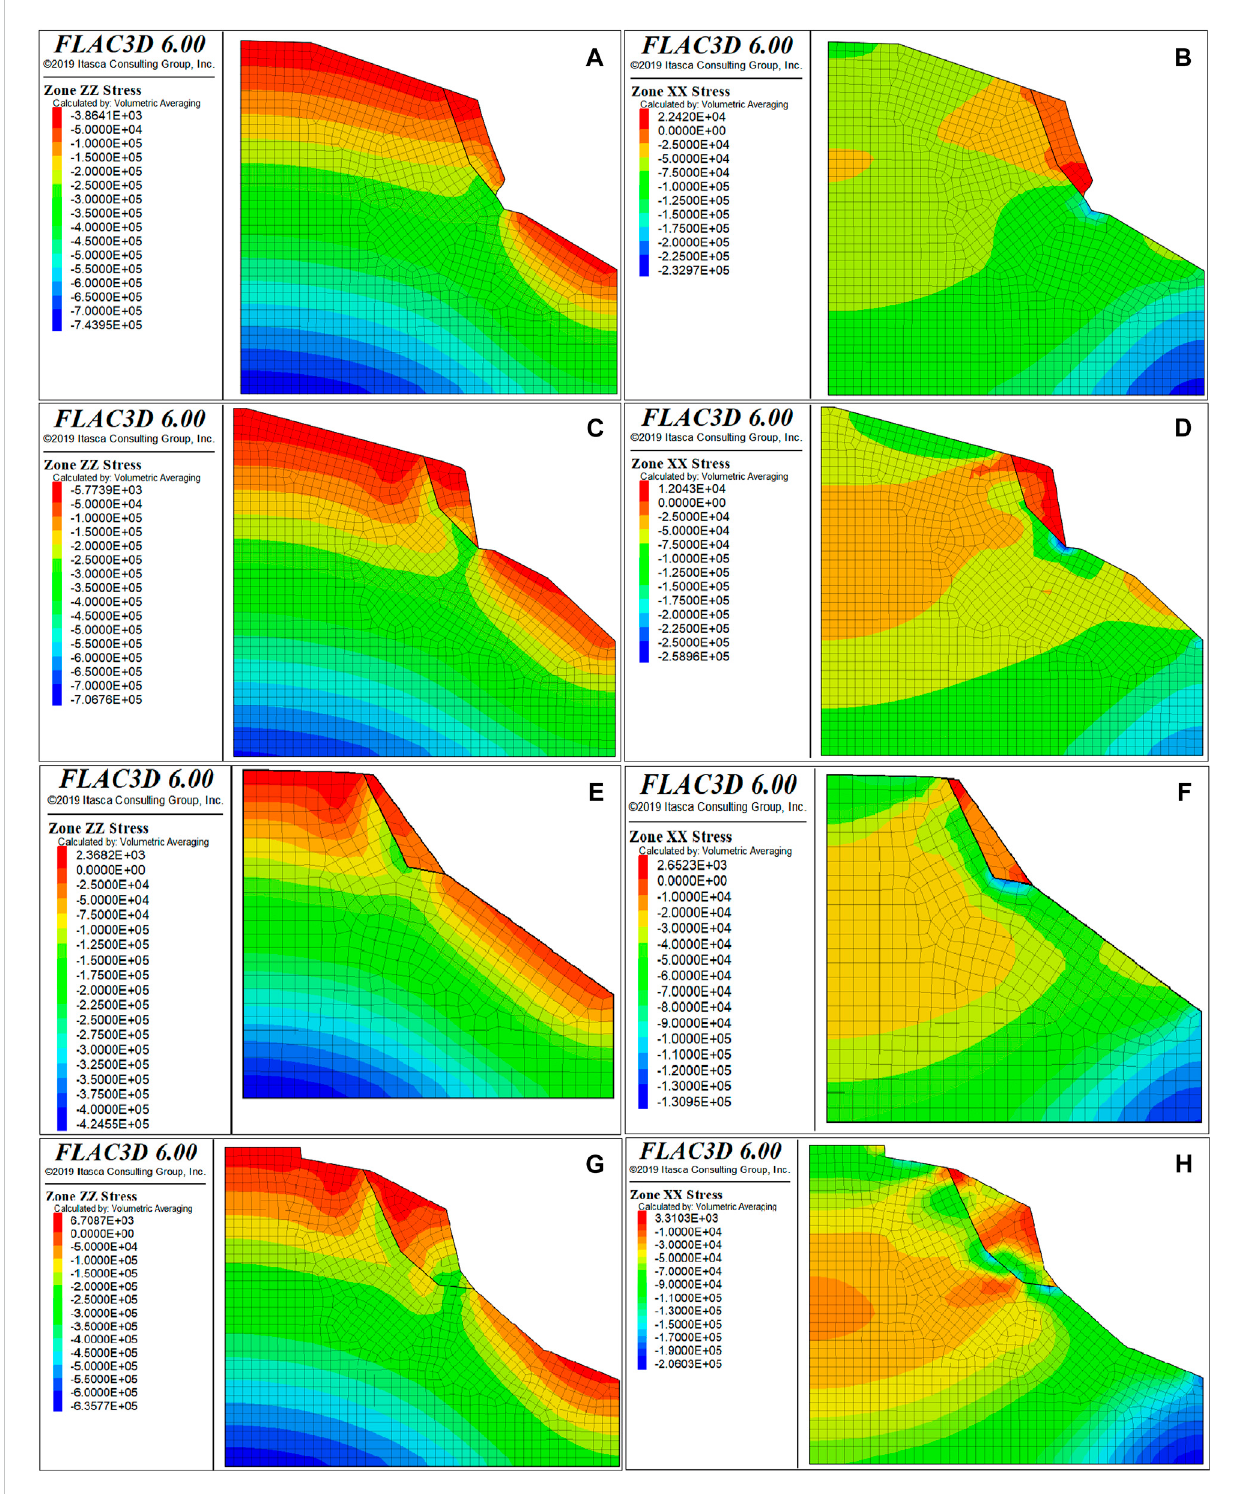
FIGURE 6 Initialstressstate. (A) VerticalstressofW1. (B) HorizontalstressofW1. (C) VerticalstressofW2. (D) HorizontalstressofW2. (E) VerticalstressofW6. (F) Horizontal stress of W6. (G) Vertical stress of W7. (H) Horizontal stress of